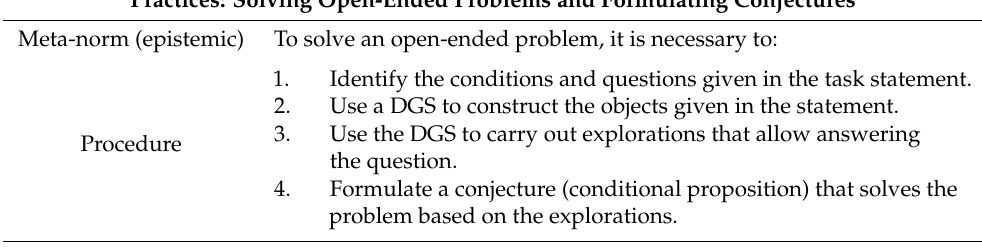
Table 1. Norms and practices of the course related to the theorem-construction